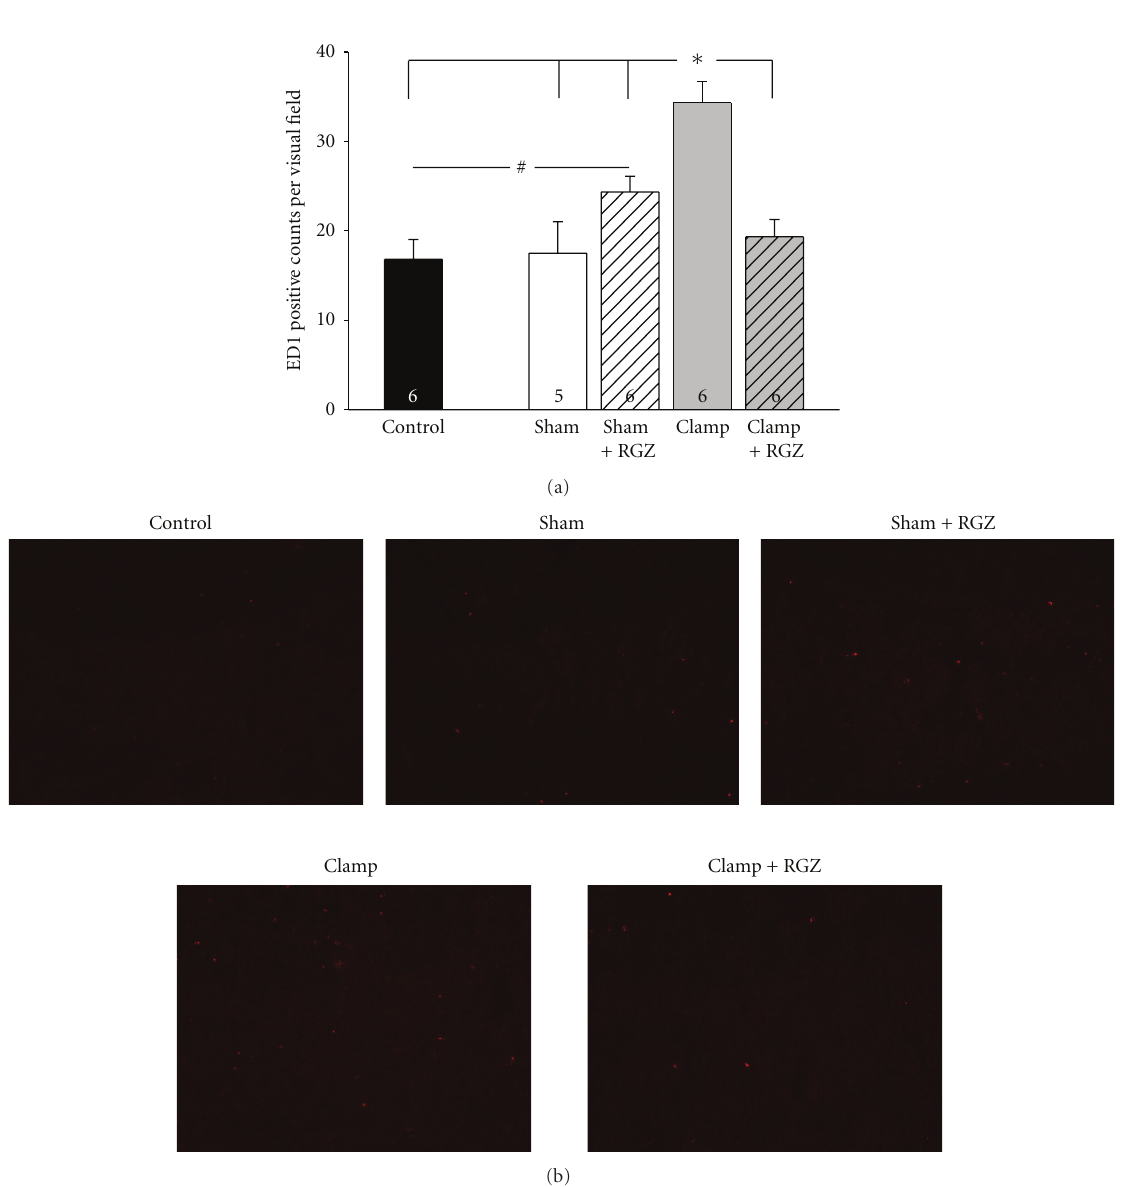
Figure 6: E ff ect of 5 mg/kg rosiglitazone (RGZ) on invasion of ED-1-positive cells (monocytes/macrophages) in renal cortex of Sprague- Dawley rats in renal I/R injury. (a) ED-1-positive cells were detected in renal cryostat sections by immunofluorescence as described in Section 2. (a) Macrophage/monocyte invasion is given as the amount of ED-1-positive cells per visual field. n as indicated. ∗ and # indicate statistically significant di ff erence with P < 0 . 05. (b) Representative immunohistochemistry images of the renal cortex (magnification 1: 10) after ED1 staining are depicted. Respective groups as indicated on the